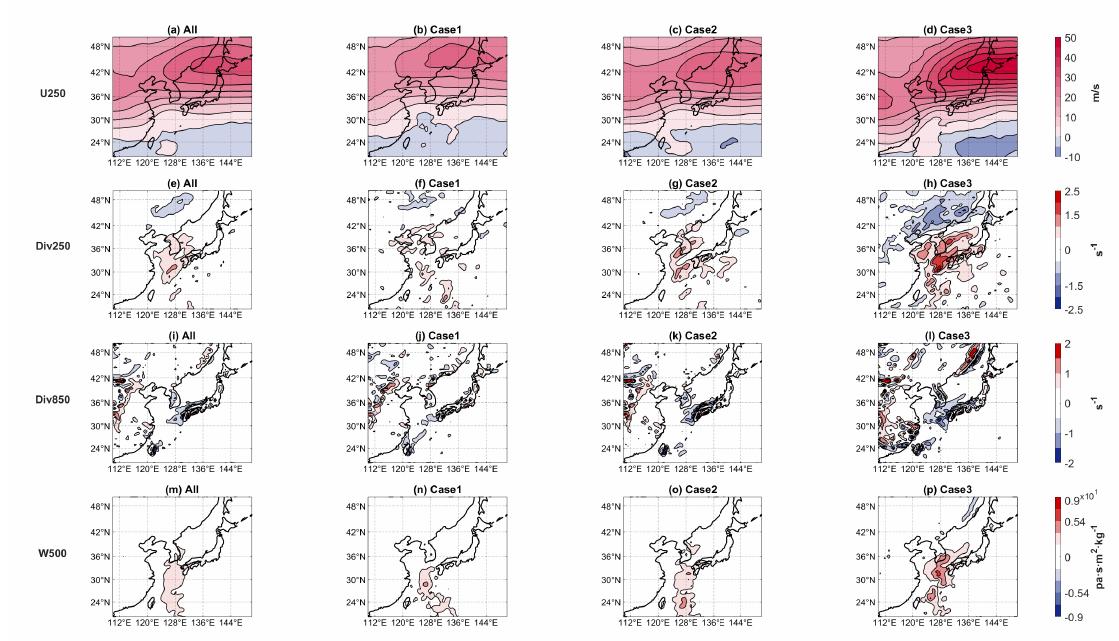
Figure 5. The composite maps of the 250-hPa zonal wind ( a – d ), divergence at the 250 hPa ( e – h ) and 850 hPa ( f – l ), and 500-hPa pressure velocity ( m – p ) during three days before TCs arrived at 30° N for all and three